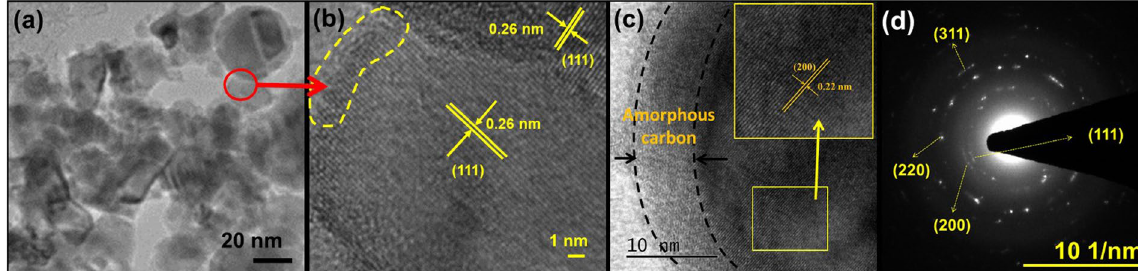
Figure 3. ( a ) TEM micrograph of 10C800 showing agglomeration of core shell structure of carbon coated NbC NPs; ( b ) HR microstructure of marked circle in 4(a) showing inter-planar spacing of plane (111) of NbC, ( c ) HR micrograph of NbC NP showing carbon coating (marked with black dotted region) on NbC particle and inset shows the lattice fringes corresponding to (200) plane; ( d ) selected area electron diffraction pattern of agglomerated NbC NPs (shown in 4a) depicting poly-crystallinity.